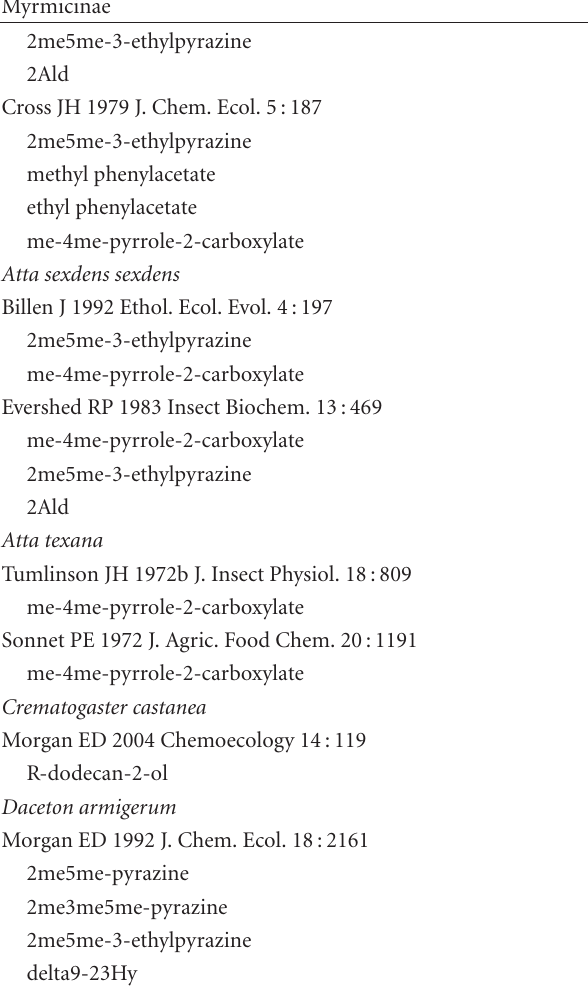
Table 1: Chemical compounds reported in trail pheromones of ants. All data were extracted from Pherobase [1].